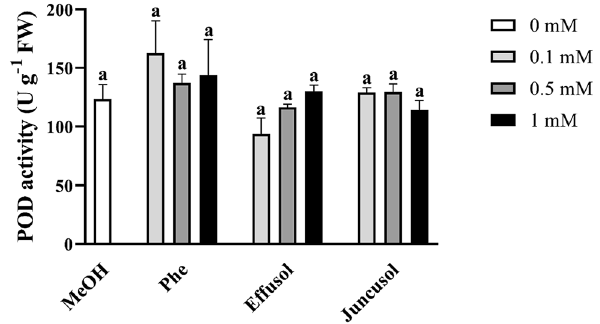
Figure 11. POD activity of seedlings treated with Phe, effusol and juncusol at different concentrations compared to MeOH. Data are presented as the mean ± SE (n = 3). Different letters indicate significant differences between the values of the treatments (P < 0.05) analysed by Tukey’s post-hoc test.